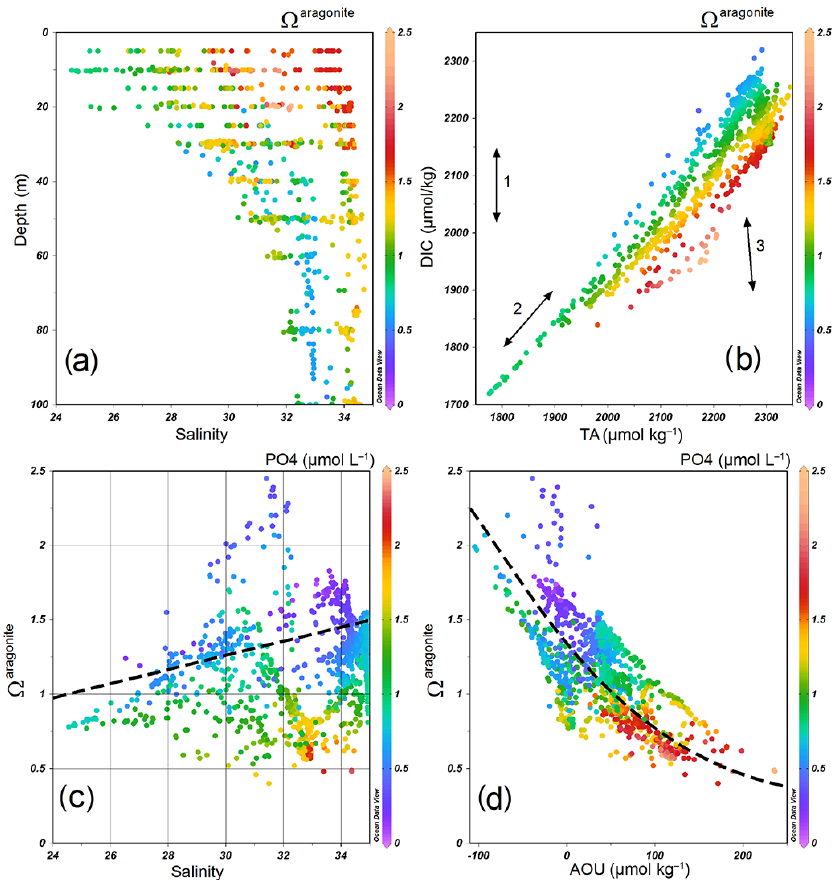
Figure 7. Plot of (a) salinity versus depth (b) DIC versus TA, both colour-coded by (cid:127) aragonite , and (c) (cid:127) aragonite versus salinity and (d) (cid:127) aragonite versus AOU, both colour-coded by PO 4 . In (b) arrows are drawn where the slope are to illustrate the impact by air–sea CO 2 gas exchange (1), dilution of water with zero DIC and TA (2) and primary production (down) and decay of organic matter (up) (3). The location and length of the arrows are arbitrary. In (c) a line is drawn that represents the dilution of Atlantic layer water with water of zero S , DIC and TA, and in (d) a line is drawn that represents a typical surface water that is impacted by primary production and decay of organic matter. Details of these lines are given in the text.